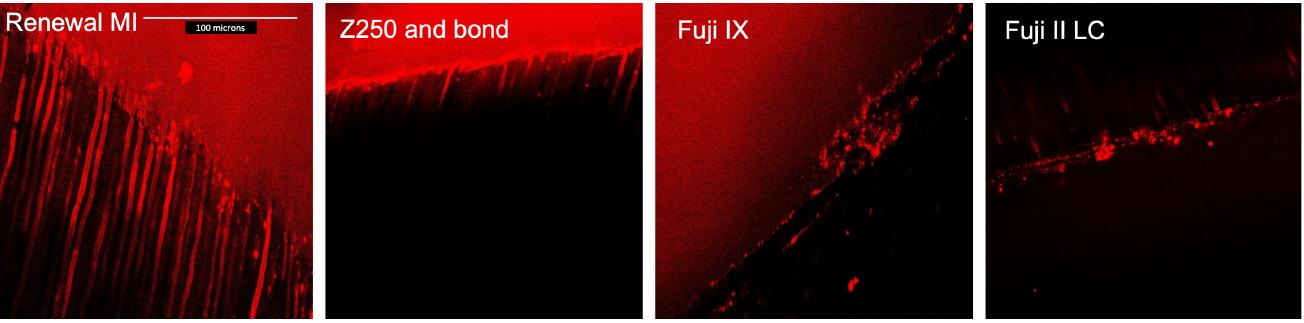
Figure 5. CLSM images of resin tags formation within demineralized dentine by Renewal MI, Z250, Fuji IX or Fuji II LC. All images are of areas 204 µm × 204 µm.